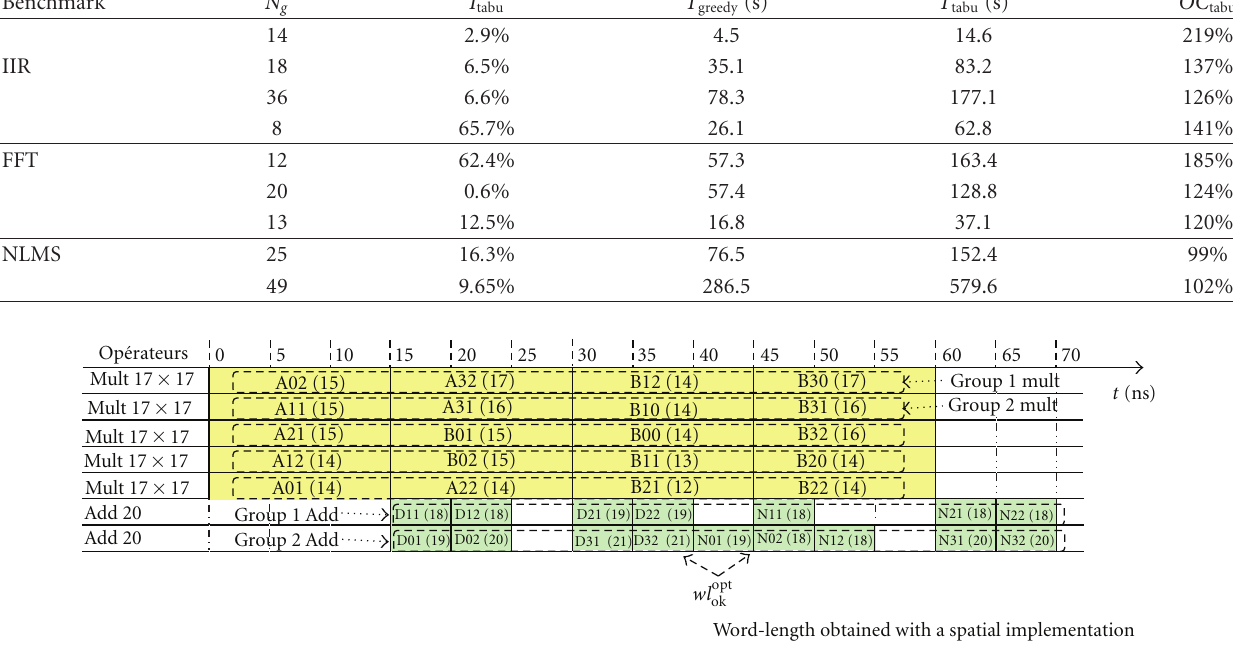
Figure 7: Scheduling of the 8th-order IIR filter obtained for the first iteration.